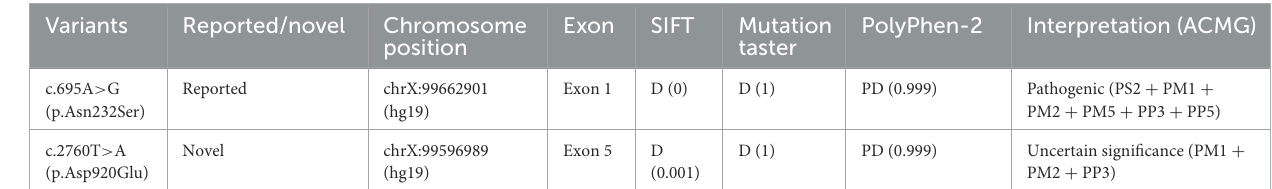
TABLE 2 Sequencing result and interpretation of the PCDH19 variant.